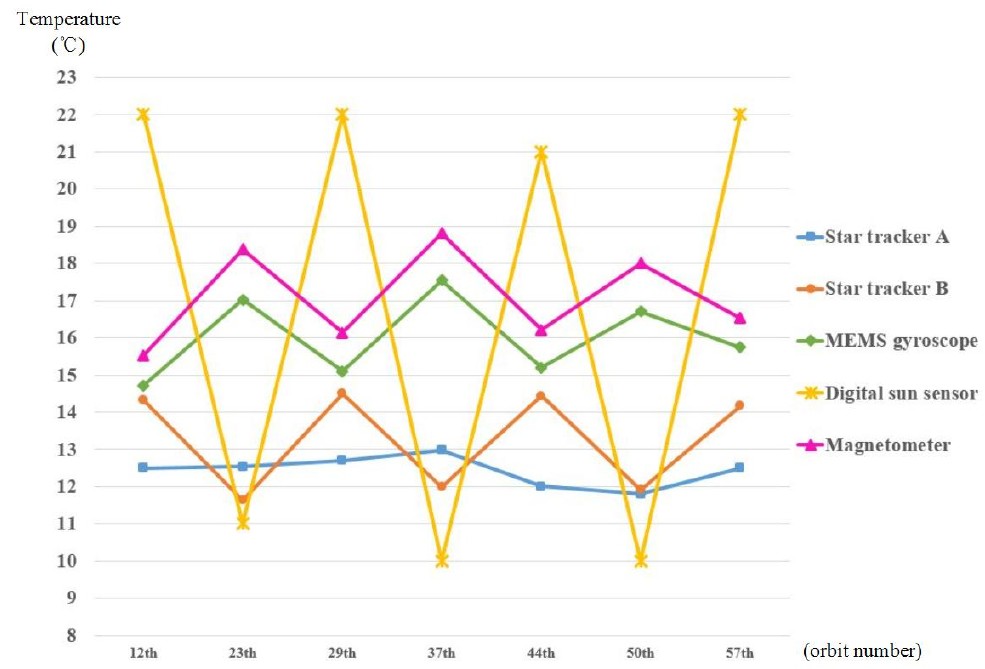
Figure 16. Temperature variation curve of the outside instruments in the Luojia 1-01.